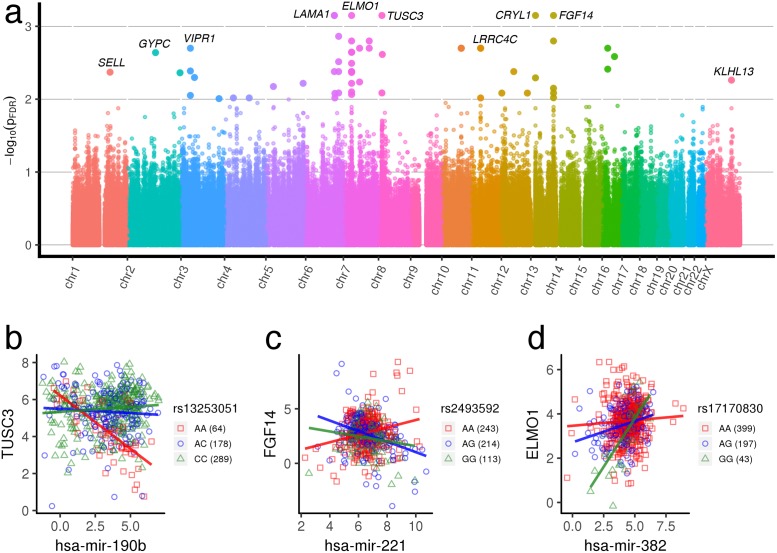
Breast cancer regQTLs.(a) Manhattan plot of regQTL −log10
FDR values in TCGA BRCA data. All gene-miRNA-SNP interactionp-values mapped to the location of the SNP in the genome. Observations are colored by chromosome. p-values are adjusted for the False Discovery Rate. A selection of strongly differentially regulated genes have been highlighted; others may be found using the mirSNP Shiny app or in the full data tables online. (b, c, d) Examples of breast cancer gene-miRNA-SNP trios with significant regulatory differences across genotypes (bottom). All trio interactions pFDR < 0.005. More trios are indicated in S1 Text.